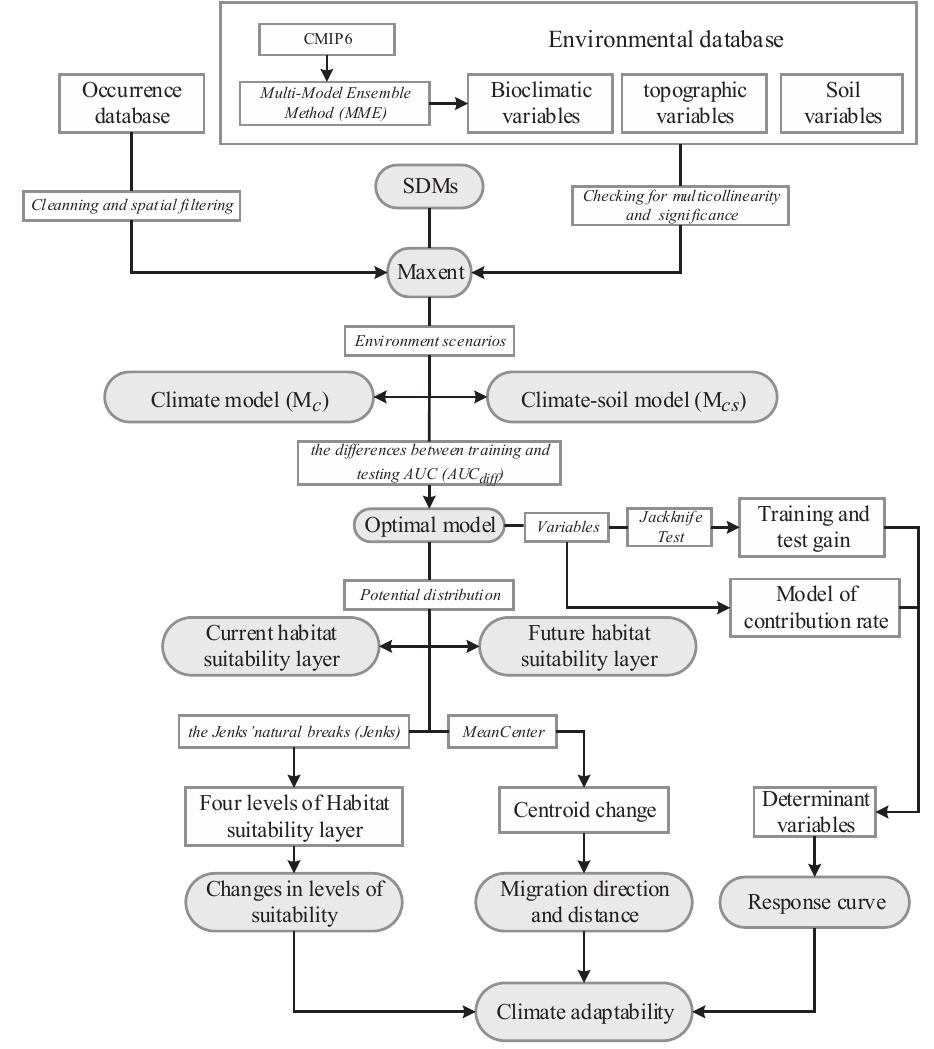
Figure 1. The process of model construction and